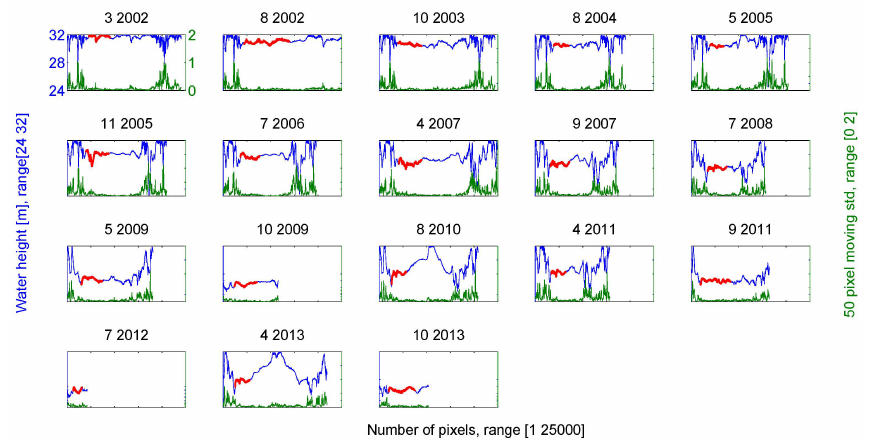
Figure 5. ( Left ) Boundary pixels of the East Aral Sea obtained from Landsat mask at different time points: blue line is the entire boundary vector (EBV), red portions are pixels from the selected region boundary (SRB); ( Right ) 50-pixel moving standard deviation of